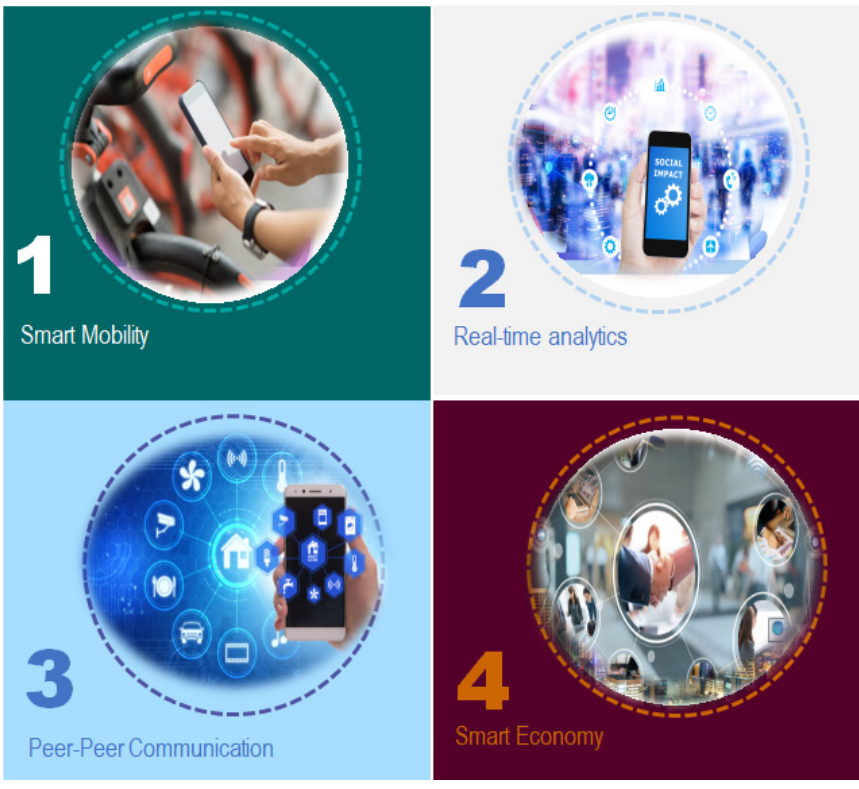
Figure 1. Four pillars of a smart city.